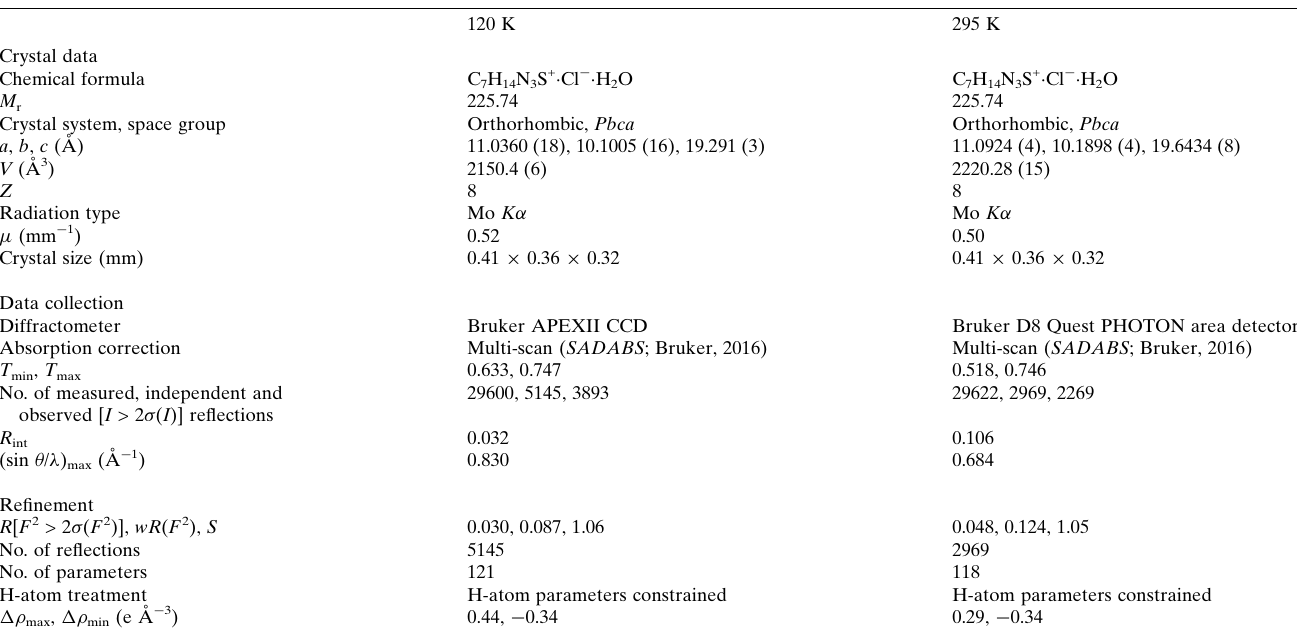
Table 3 Experimental details. Crystal data Chemical